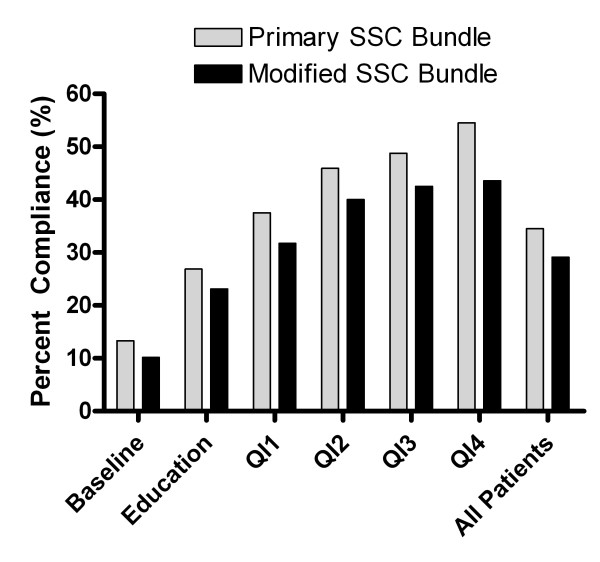
Surviving Sepsis Campaign bundle completion. Primary Surviving Sepsis Campaign (SSC) Bundle completion versus Modified SSC Bundle completion (includes lactate clearance) from baseline to the end of the study period. QI, quality improvement.